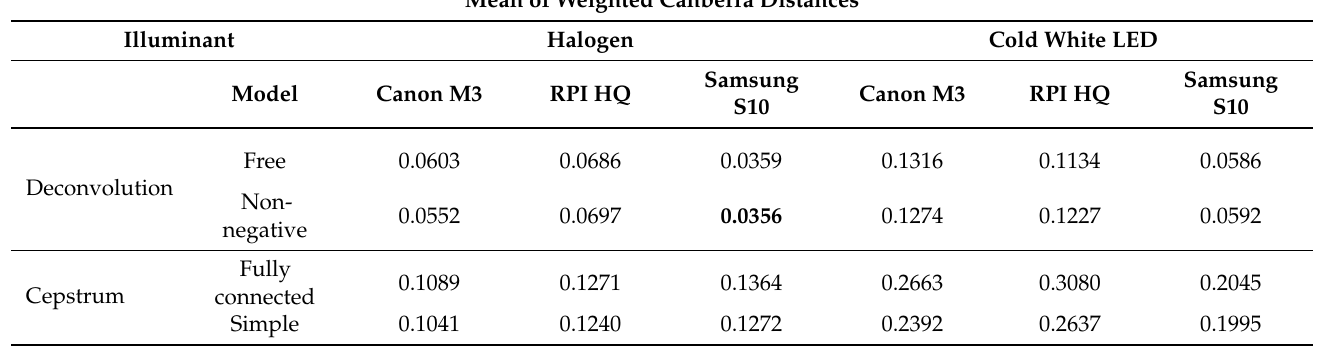
Table 1. Mean of weighted Canberra distances between estimated and ground truth spectra for camera, illuminant, method, and model combinations. Smaller numbers mean better accuracy w.r.t. ground truth spectra. The best result is indicated in boldface.